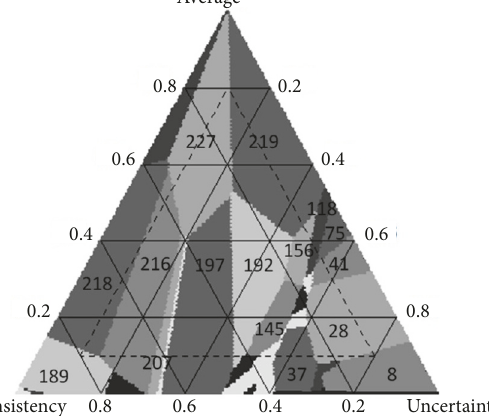
Figure 10: Mixture plot showing the 35 optimal strategies selected for different weighting choices based on using the additive desirability function (DF). The 16 most robust strategies, which are optimal for at least 1% of the total weighting area, are labeled with index numbers.